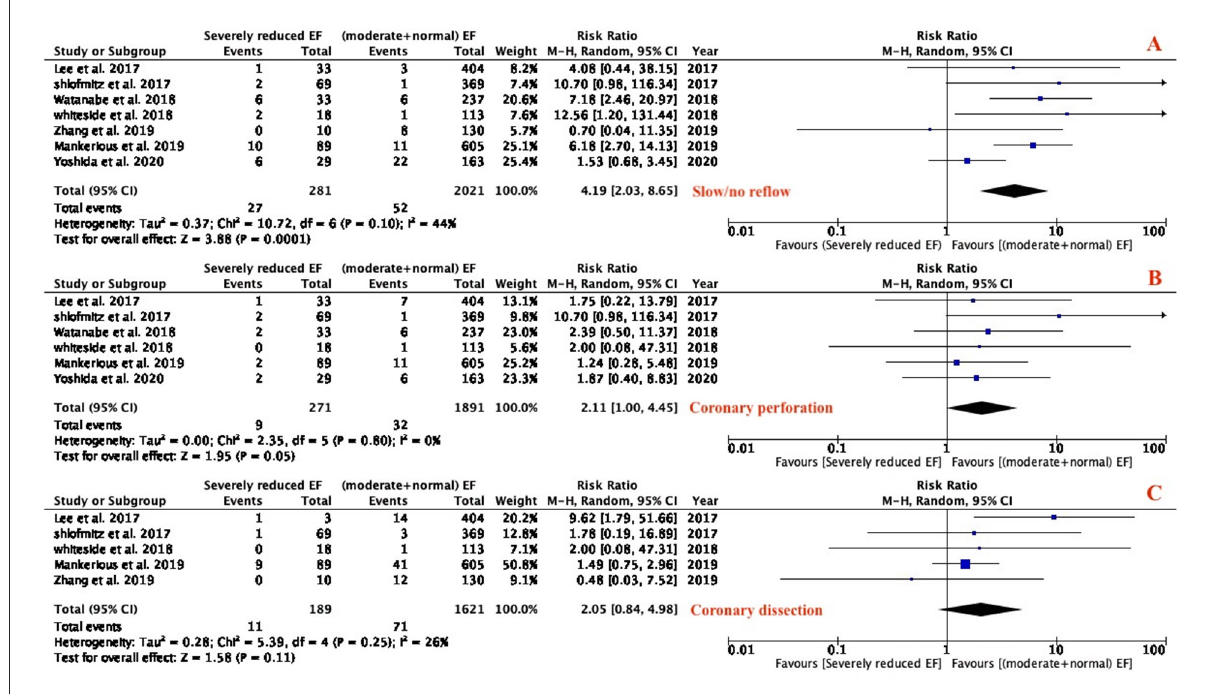
FIGURE4 Forest plot of procedural outcomes (slow/no reflow, coronary perforation,